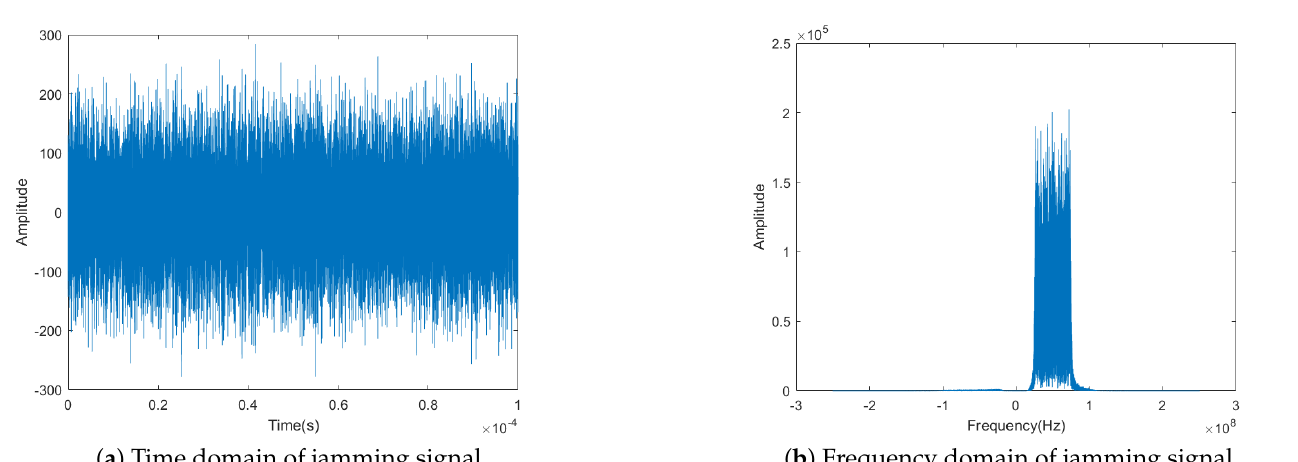
Figure 7. Time domain and frequency domain of the jamming signal.